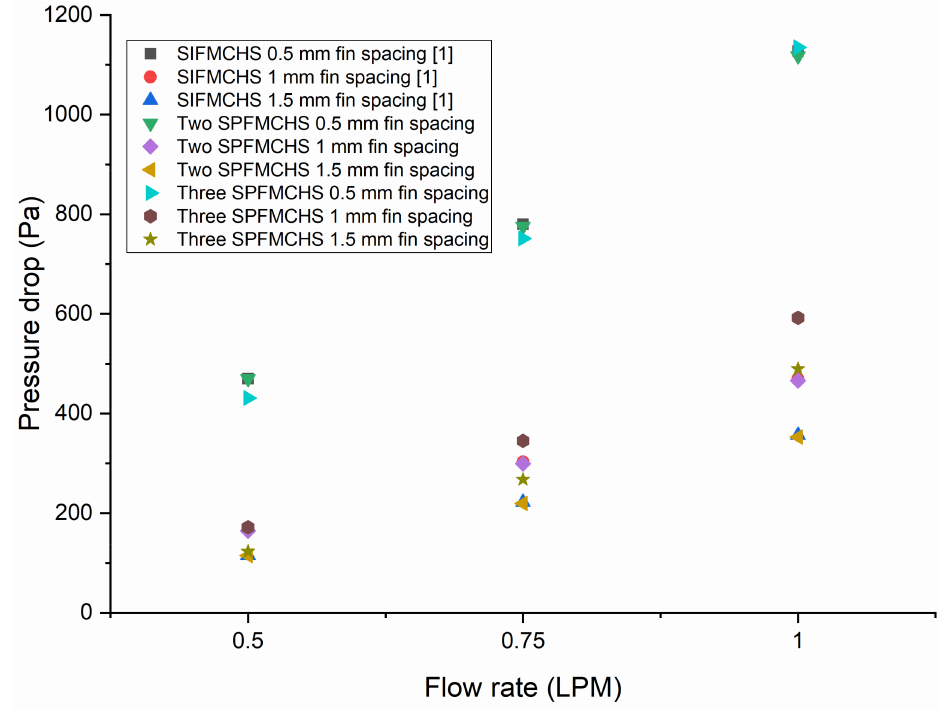
Figure 14. Pressure drop with volumetric flow